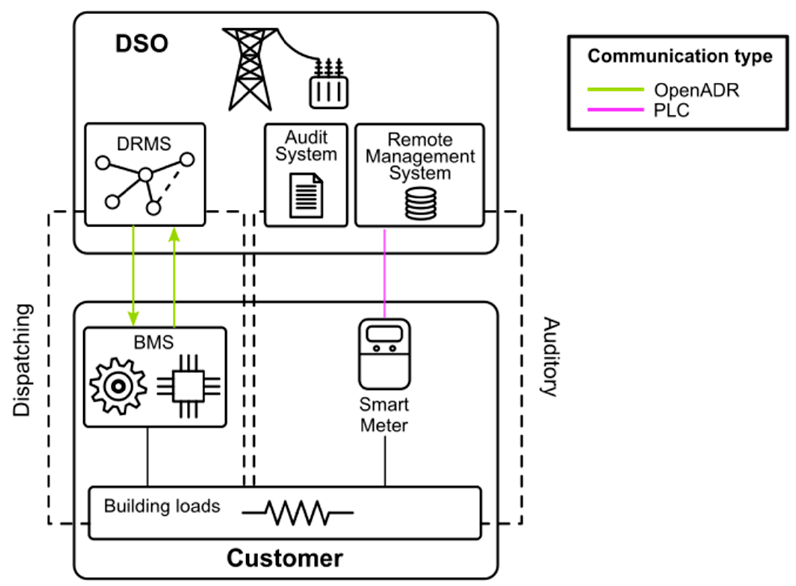
Figure 2. Structure and communication of DSO and customer systems for DSM/DR and auditing.